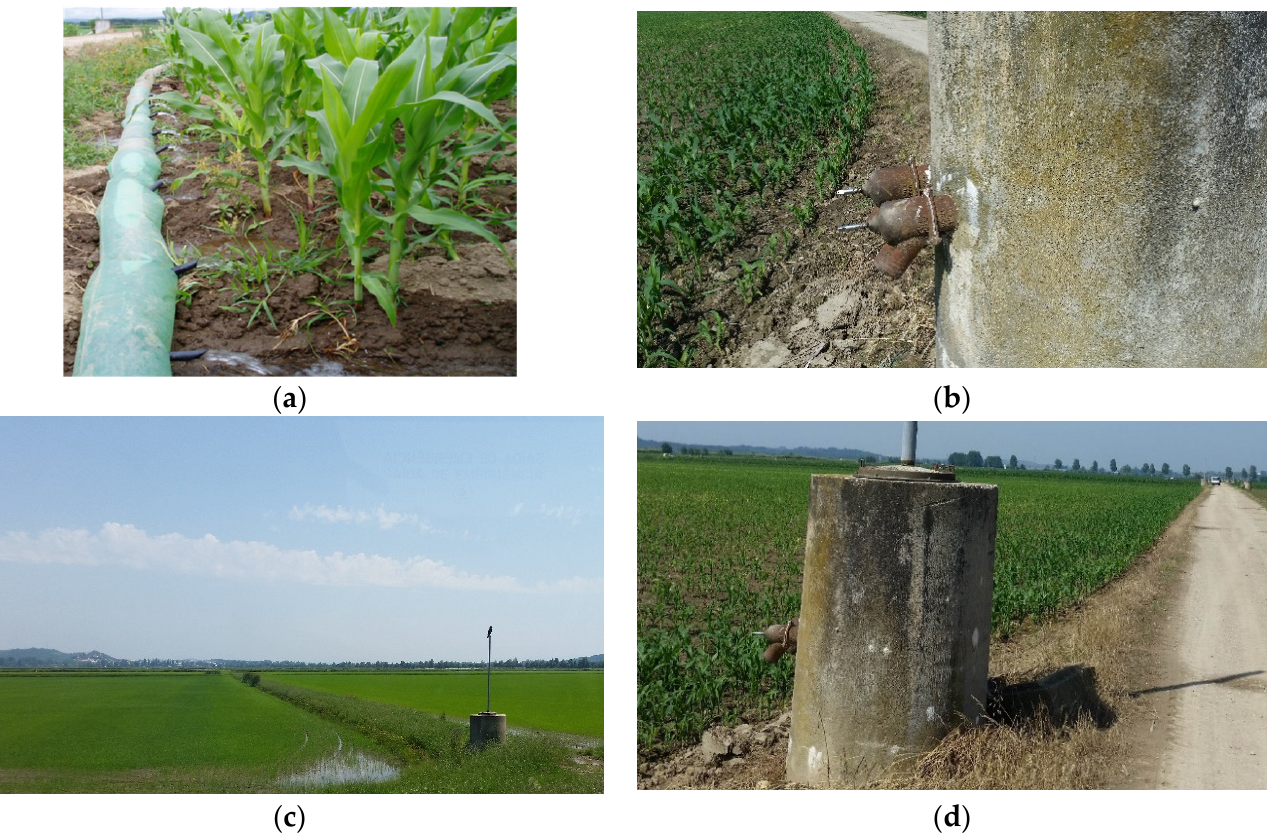
Figure 9. Example of an irrigation system for maize crops (extracted from [41]) ( a ), watering point ( b ), drainage of rice crops ( c ) and rural roads ( d ).